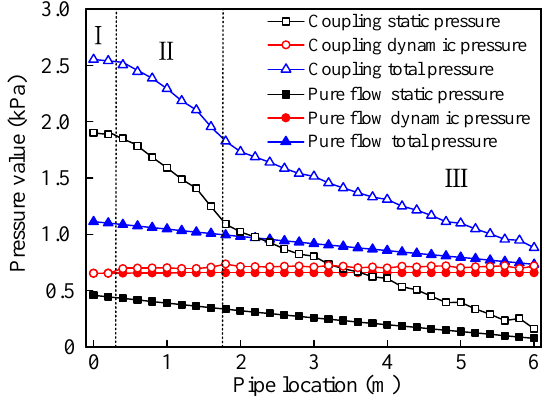
Figure 2. Pressure variation in a horizontal pipe.